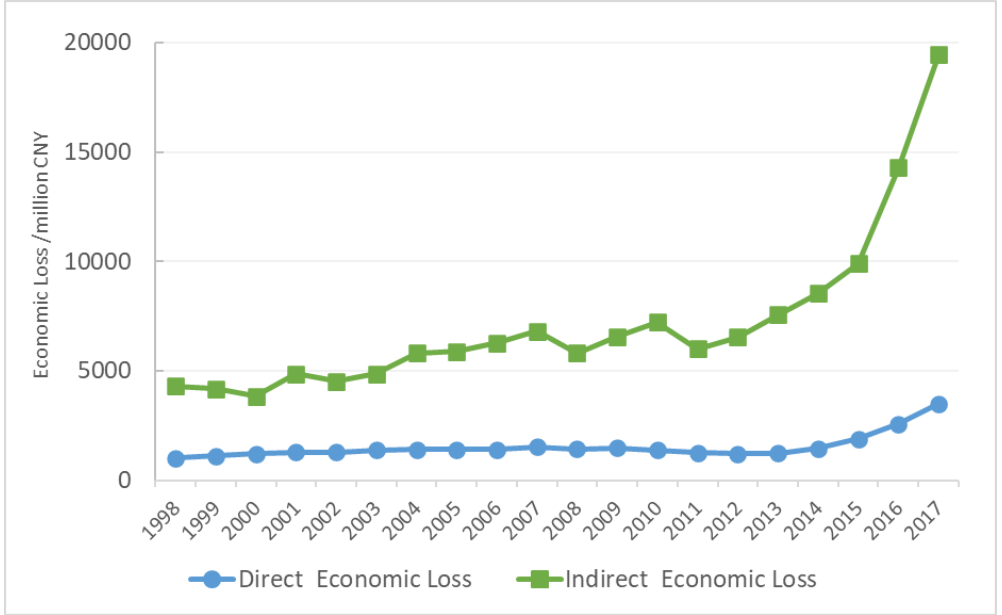
Figure 3. Trends of economic loss of pine wood nematode disease in mainland China from 1998 to 2017. 3.3. Economic Loss of Pine Wood Nematode Disease at Provincial Scale in Mainland China from 1998 to 2017